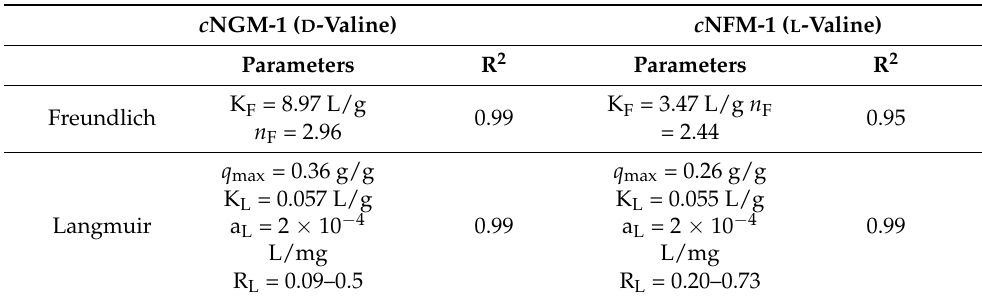
Figure 4. Fitting for isotherms curves based on a Langmuir isotherm model for adsorption of the favoured enantiomers of valine in ( a ) c NGM-1 and ( b ) c NFM-1 adsorbents at 25 ◦ C. Table 1. Summary of the Freundlich and Langmuir isotherm constants and comparison of linear (R 2 ) coefficients for the adsorption of the favoured enantiomers of valine in c NGM-1 and c NFM-1